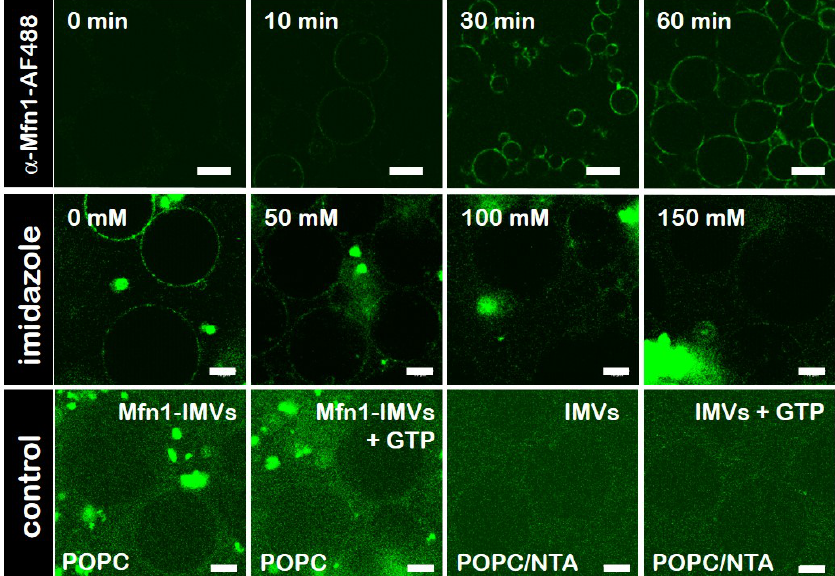
Figure 3. Specific binding of hs Mfn1 protein to giant unilamellar vesicles (GUVs) . Confocal fluorescence microscopy images showing the time series of the binding ( top row ) and release ( middle row ) of α -Mfn1-488 antibody to hs Mfn1 immobilised on the surface of POPC/DOGS-NTA GUVs. Prior to the incubation with POPC/DOGS-NTA GUVs, hs Mfn1 itself was incubated with α -Mfn1-488 (green signal). To release the bound hs Mfn1 from the POPC/DOGS-NTA GUVs, increasing amounts of imidazole were added to the sample. Control assays ( bottom row ), where POPC GUVs (in the absence of DOGS-NTA) were incubated with Mfn1-IMVs ( bottom row , Mfn1-IMVs) or POPC/NTA GUVs were incubated with solubilised E. coli IMVs ( bottom row , IMVs) showed no labelling of the GUV contour upon incubation with α -Mfn1-488. To visualise the presence of GUVs in the fluorescence images of the control experiments, the raw data were not corrected for signal-to-noise ratios. The addition of GTP to these samples did not promote adhesion of vesicles. Scale bars are 10 µ m. Each control was repeated independently at least three